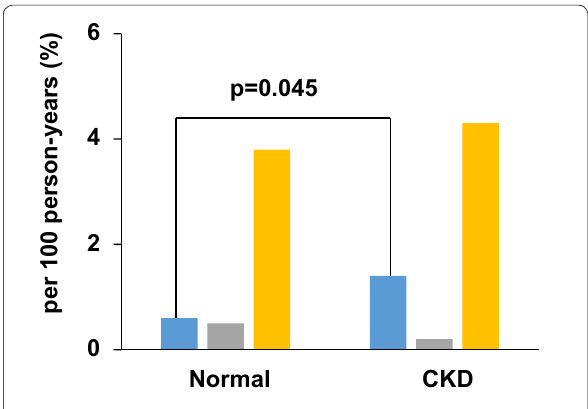
Fig. 6 Comparison of adverse outcome between normal and CKD patients. Stroke/TIA was significantly higher in CKD patients (1.4 vs.